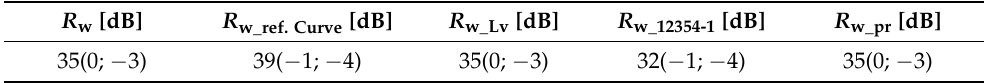
Table 5. Weighted sound reduction indices, R w ( C ; C tr